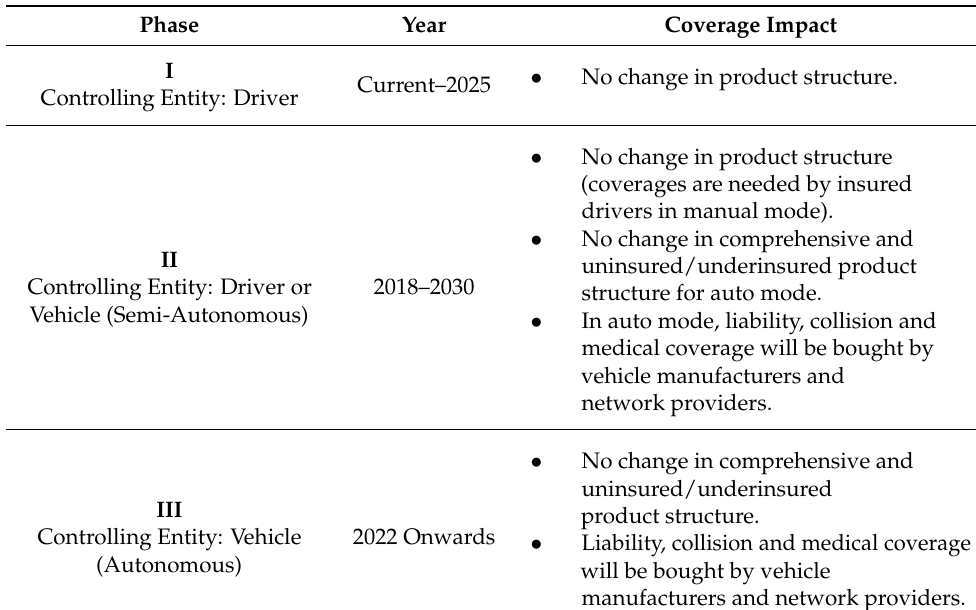
Table 2. Changing coverages adapted from